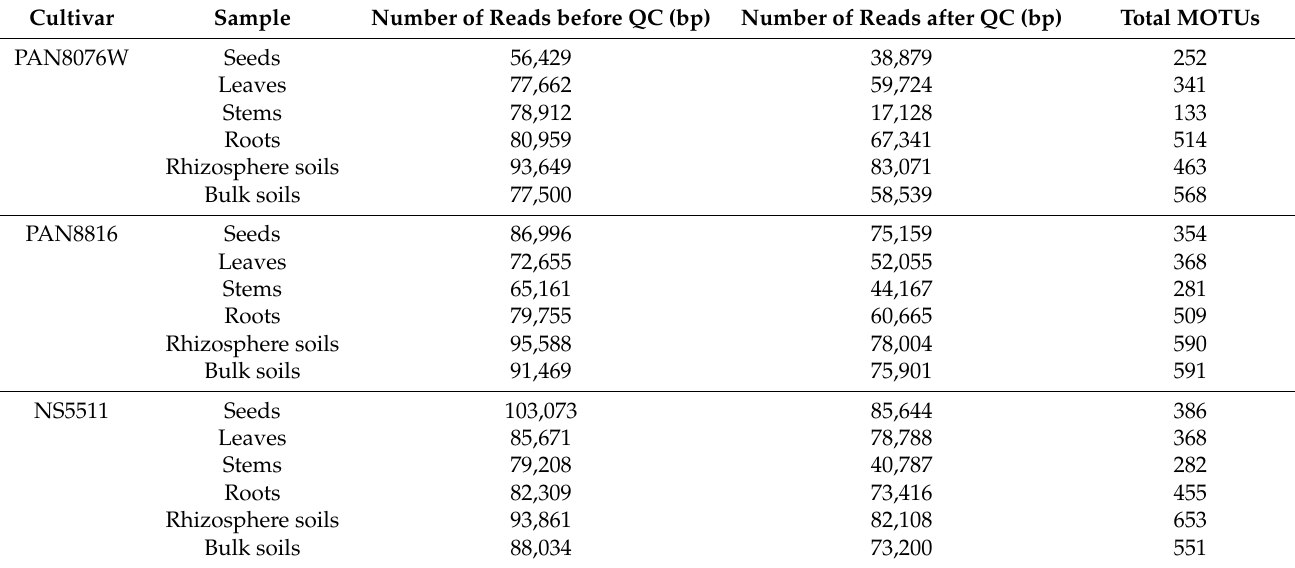
Table 2. Sequencing results and number of Molecular Operational Taxonomic Units (MOTUs) for the three sorghum cultivars investigated, before and after quality control